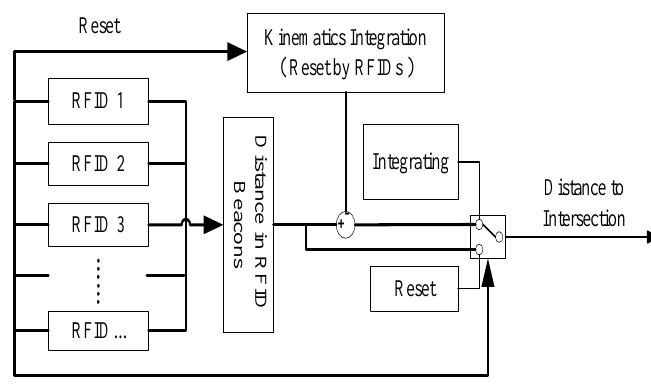
Figure 4. Kinematic integration